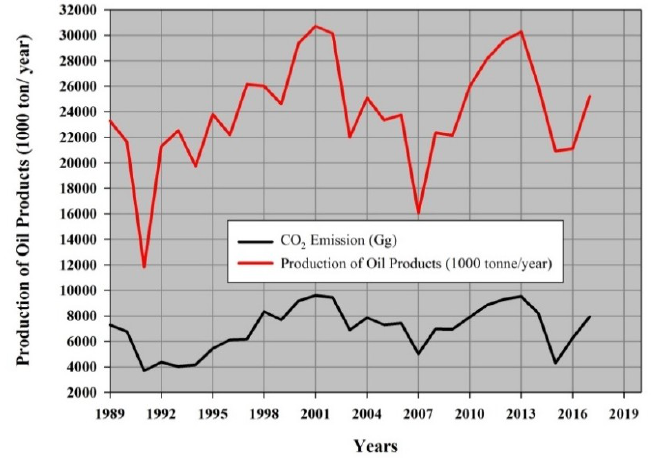
Figure 9. Production of oil derivatives (Gg/year) and CO 2 emissions from oil refining in Iraq from 1989 to 2017.